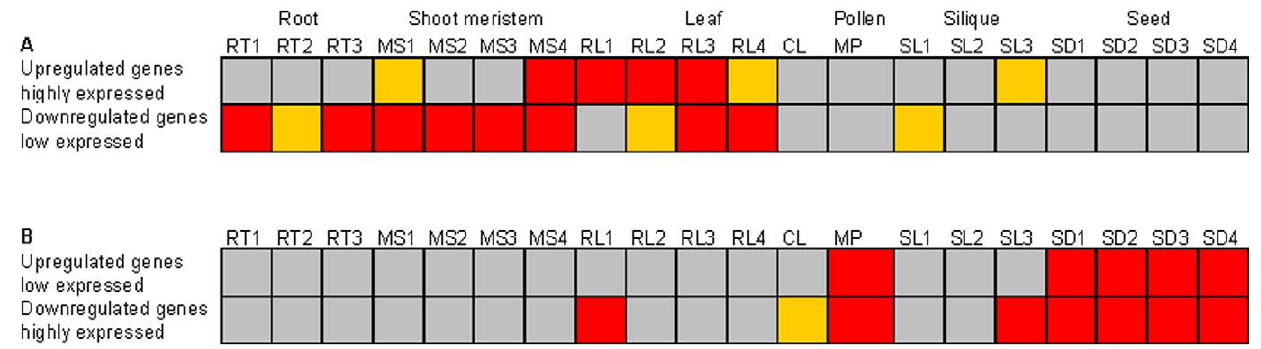
Figure 5. Tissue specificity of genes up- and down-regulated in miRNA biogenesis mutant inflorescences. Grey, yellow and red indicate no significance, significance at P , 0.05, and significance at P , 0.01 respectively. (A) Tissues in which genes up-regulated in the mutants had high abundance, and tissues in which genes down-regulated in the mutants had low abundance. Colors in the top row indicate if genes up-regulated in the mutants are expressed at a significantly high level in the wild type tissue. Colors in the bottom row indicate if genes down-regulated in the mutants were expressed at a significantly low level in the wild type tissue. (B) Tissues in which genes up-regulated in the mutants had low abundance, and tissues in which genes down-regulated in the mutants had high abundance. Colors in the top row indicate if genes up-regulated in the mutants were expressed at a significantly low level in the wild type tissue. Colors in the bottom row indicate if genes down-regulated in the mutants were expressed at a significantly high level. The key for tissue type abbreviations is: RT1: root, 7 days; RT2: root, 15 days; RT3: root, 17 days; MS1: shoot apex, vegetative plus young leaves; MS2: shoot apex, vegetative; MS3: shoot apex, transition; MS4: shoot apex, inflorescence; RL1: rosette leaf # 4; RL2: rosette leaf # 6; RL3: rosette leaf # 8; RL4: rosette leaf # 10; CL: cauline leaf; MP: mature pollen; SL1: silique, with seeds stage 3; SL2: silique, with seeds stage 4; SL3: silique, with seeds stage 5; SD1: seed, stage 6; SD2: seed, stage 7; SD3: seed, stage 8; SD4: seed, stage 9.